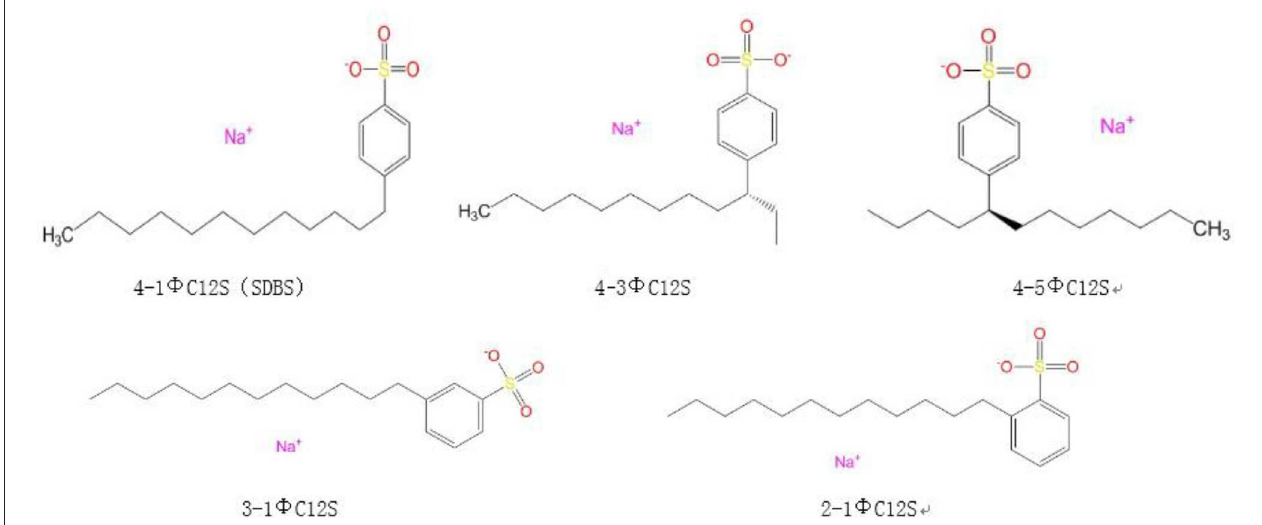
FIGURE 1 | Sodium dodecyl benzene sulfonate (SDBS) and its isomer models. The leading digit 2, 3, or 4 indicates that the long alkyl chain is in the ortho, interposition, or para position of the benzene ring, respectively; 8 represents the benzene ring; 12 is the number of carbon atoms in the long alkyl chain; the digits 1, 3, or 5 before the 8 indicate that the benzene ring is at the position 1#, 3#, or 5# of the long alkyl chain; and S represents the sulfonate.